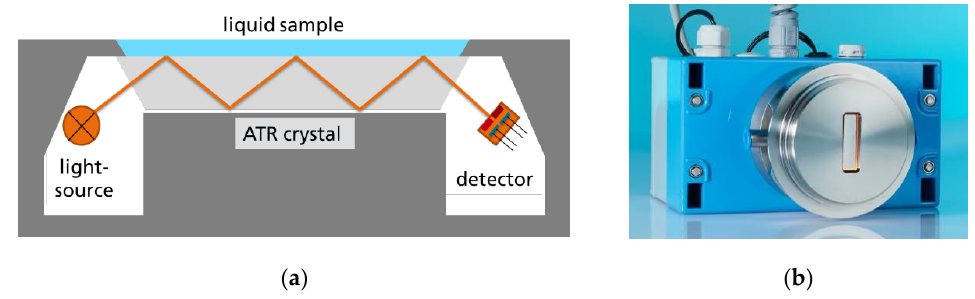
Figure 1. ( a ) Concept of a liquid sensor using a planar ATR element [22] and ( b ) picture of a later industrial sensor system for CO 2 measurements in beverages